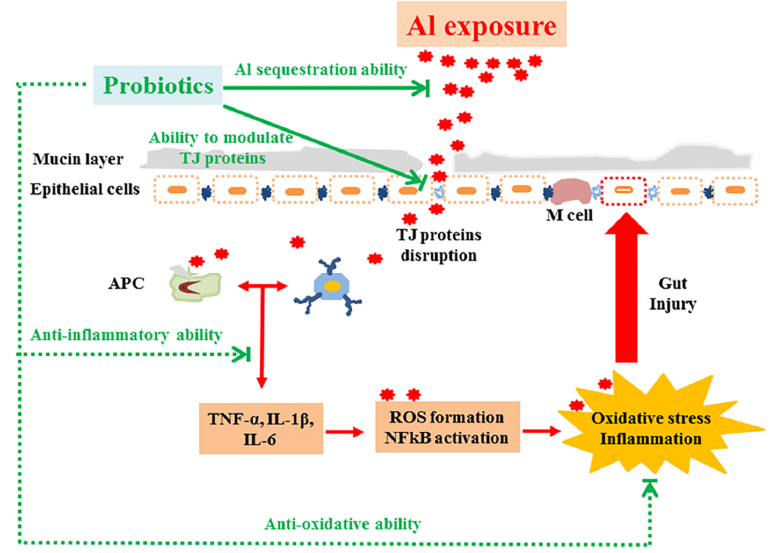
Figure 7. The potential protection mechanism of probiotics against Al ‐ induced gut injuries.